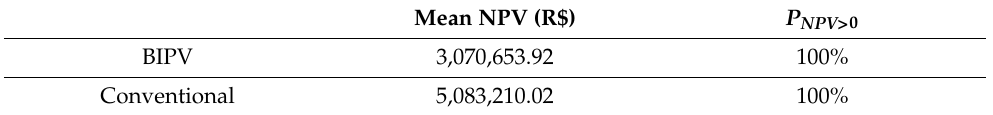
Table 8. Results of stochastic simulations of NPV for the municipality of Pau dos